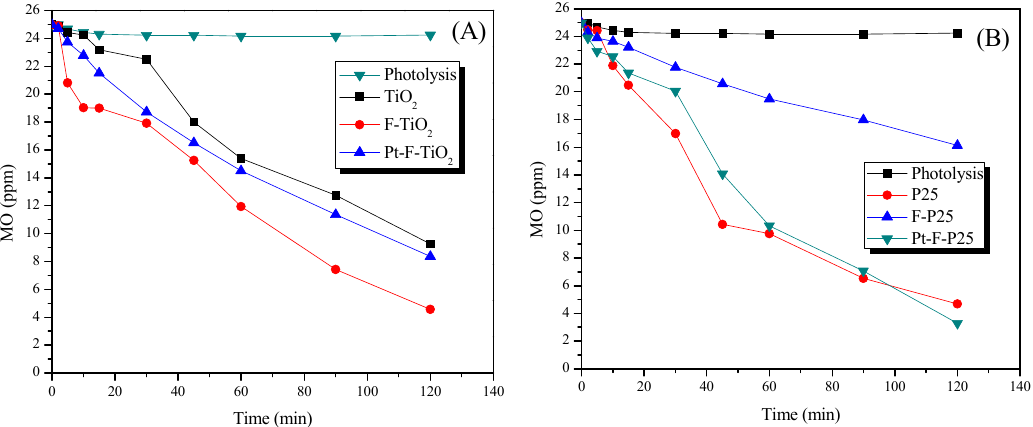
Figure 10. Evolution of MO concentration with the photoreaction time over the photocatalysts analyzed. ( A ) Lab prepared TiO 2 modified and ( B ) commercial TiO 2 modified.